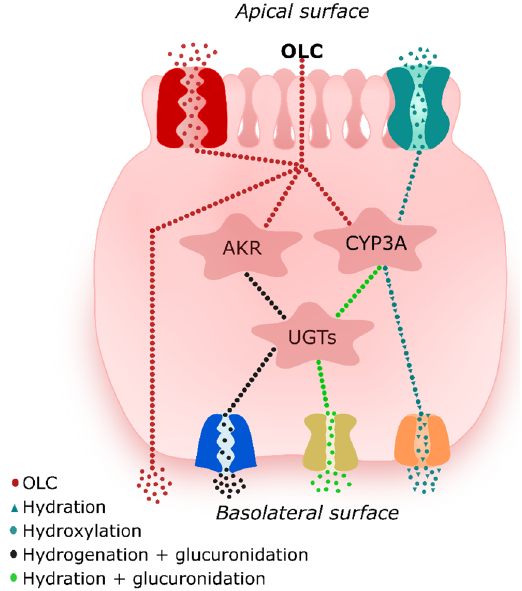
Figure 4. Tentative interactions of oleocanthal (OLC) with metabolic enzymes and transporters .